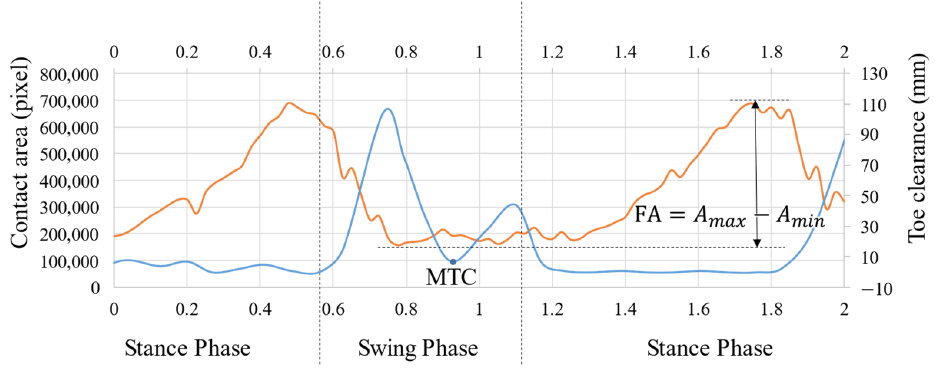
Figure 7. Representative results of the extracted contact area. The orange line represents the contact area, while the blue line represents the TC.